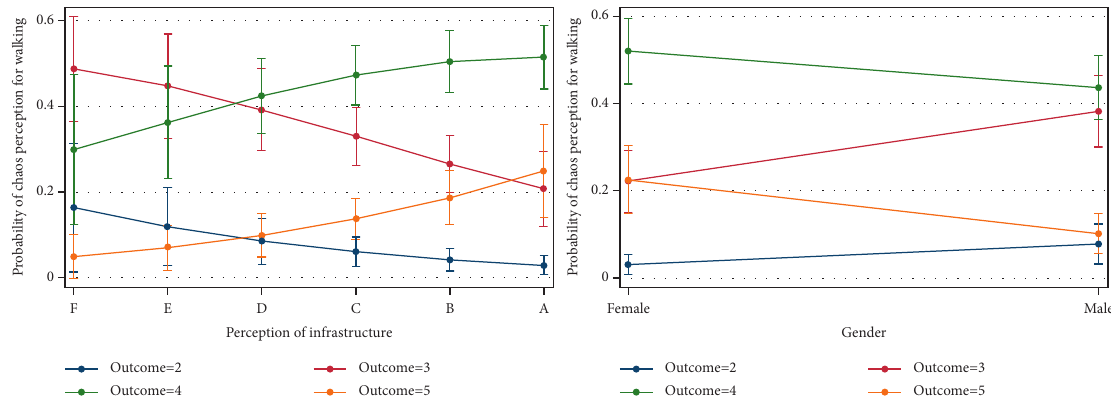
Figure 5: Predictive margins for chaos perception at 95% confidence interval. Table 6: Ordered logit models for perception of